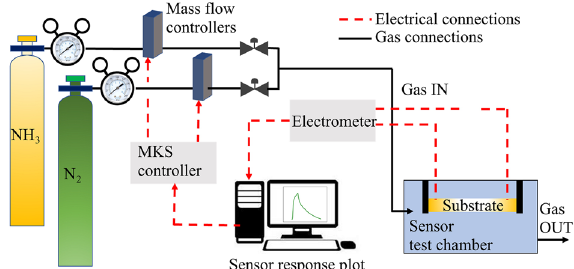
Figure 2. Schematic illustration of the sensor measurement set-up. Ammonia gas is diluted with Nitrogen 6.0 to concentrations of up to 100 ppm. During gas flow through the sensing chamber, the subsequent change in the electrical resistance of a bridge for a given externally applied voltage is recorded. The real-time performance is plotted on a computer with the help of a LabVIEW program.